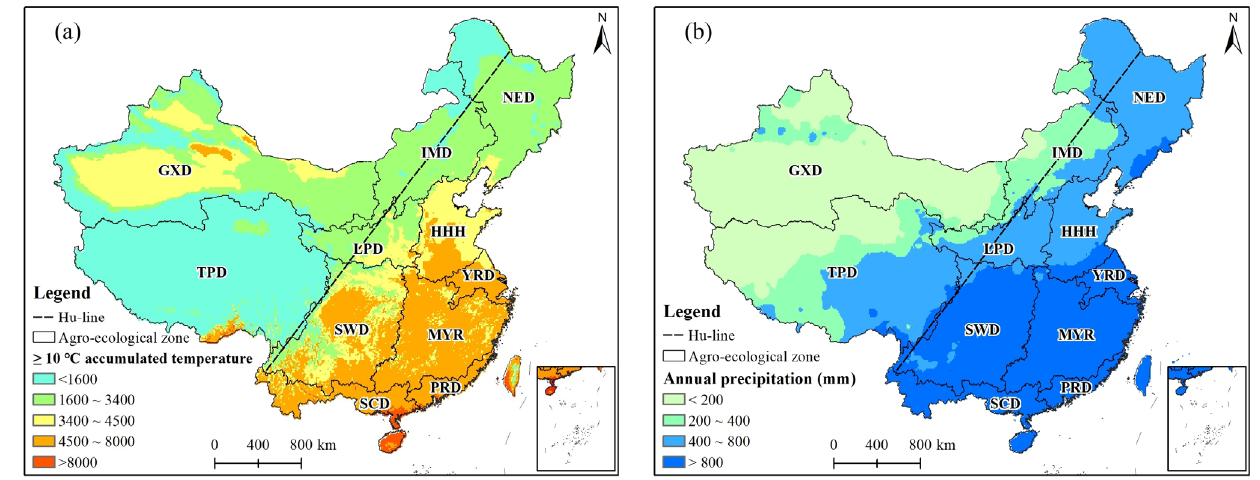
Figure 1. Agro-ecological zones, accumulative temperature above 10 °C ( a ) and averaged annual precipitation ( b ) in China. Table 1. Summary of 11 agro-ecological zones in China.